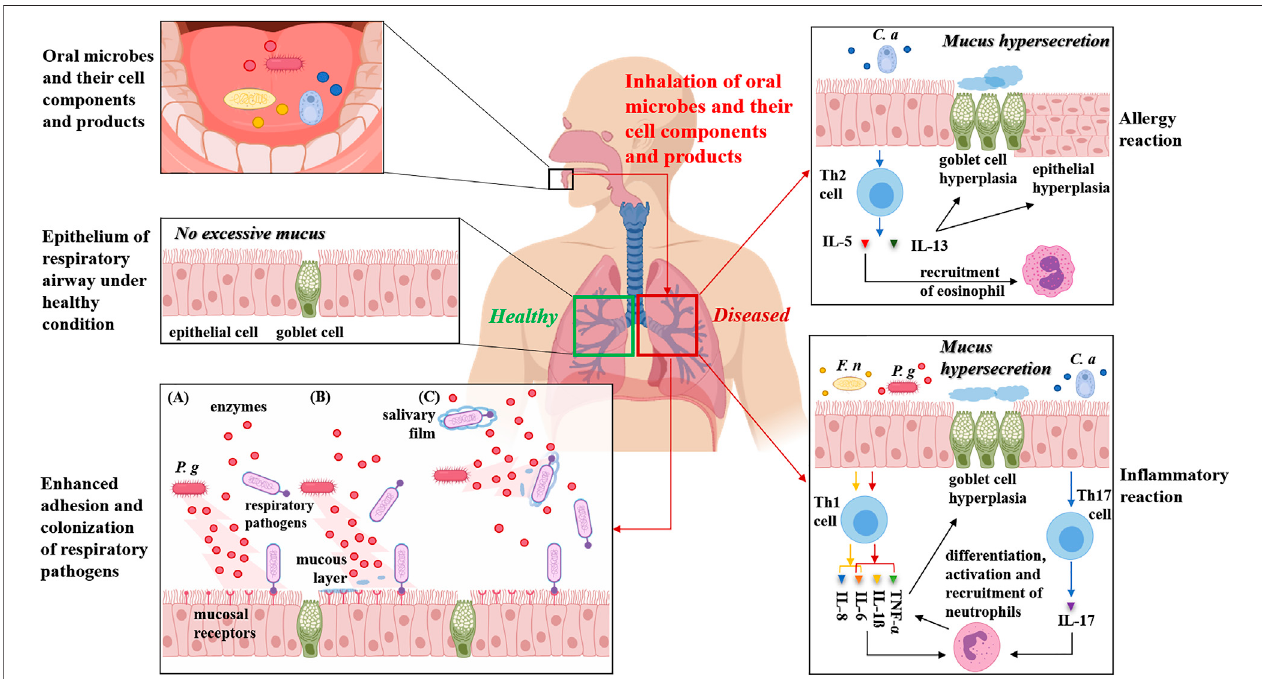
FIGURE 1 | Potential mechanisms on aspiration of oral microorganisms and their cell components and products into the lower respiratory tract to modulate immunoreactionandfacilitateadherenceandcolonizationofrespiratorypathogens.Indigenousoralmicroorganisms,aswellastheircellcomponentsandproductssuch as lipopolysaccharide, peptidoglycans, enzymes and toxins in saliva, may be inhaled into the lower respiratory tract including the lung. Here, we classify the reactions of thelowerrespiratorytracttoinvadedoralmicrobesandtheircellcomponentsandproductsintoallergyandin fl ammation.Inallergyreactionmode,take C.albicans ( C. a ) for example, the fungus and its lysates are reported to induce IL-5 and IL-13 production by Th2 cells. IL-5 activates eosinophils which is related with airway eosinophilicin fl ammation.IL-13inducesgobletcellhyperplasia resultinginincreasedmucus productionandsmoothmusclecellhyperplasiaandhyperactivity whichare prominent pathological features of allergic reaction. In in fl ammatory reaction mode, typical oral microbes such as F. nucleatum ( F. n ) and P. gingivalis ( P. g ) could induce IL-8 and IL-6 production, or soluble TNF receptors, TNF- α , IL-1ß and IL-6 production, respectively, both contributing to in fl ammation because of the subsequent differentiation,activationandrecruitmentofneutrophils.TNF- α alsoinducegobletcellhyperplasiaandmucushypersecretion.Moreover, C.albicans ( C.a )infectioncould induce Th17 CD4 + occurrence, whose main functions are the differentiation, activation and recruitment of neutrophils, which contribute to the in fl ammation and destruction of the lung tissue. In addition of effects on immunoreaction and in fl ammation, inhaled cell components and products of oral microbes (for example, P. gingivalis ) may enhance adherence and colonization of respiratory pathogens on respiratory mucosa, mainly via three ways: (A) modi fi cation or upregulating expression ofthemucosalepitheliumreceptorsbyspeci fi cenzymesorbyothercellcomponentsandproducts. (B) clearanceofthemucouslayerthatcoversthereceptorsresulting in exposure of surface receptors. (C) the salivary fi lm that protects against the colonization of pathogenic bacteria is destroyed by hydrolytic